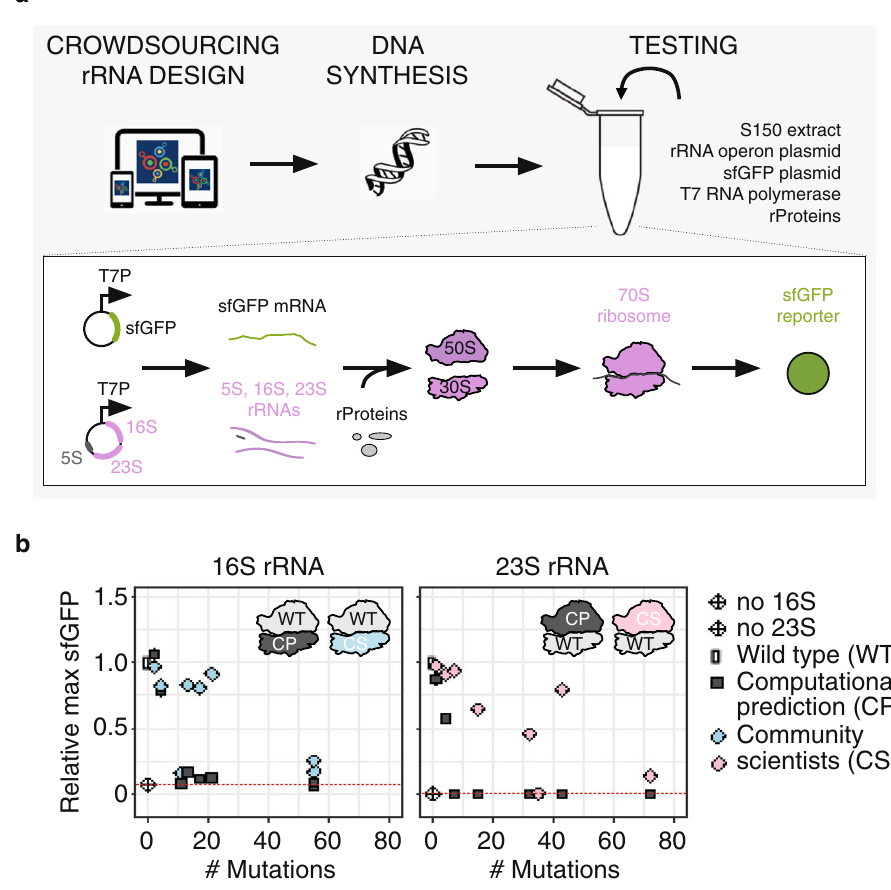
Fig. 1 | Crowdsourcing rRNA design enables functional mutant ribosomes and outperforms computational predictions. a rRNA design was crowdsourced to community scientists (CS) via the Eterna platform. In a “ pilot round ” (R0), com- munity scientists solved 16S rRNA and 23S rRNA puzzles, submitted their “ solu- tions ” alongsideadescription,andvotedontheirfavoriteeightdesignstobetested for each rRNA. The eight designs for each rRNA with the highest number of votes were synthesized and tested for activity in vitro by integrated ribosome synthesis,